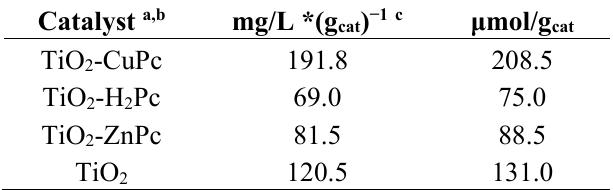
Table 3. Effect of metal on formic acid production efficiency at pH =